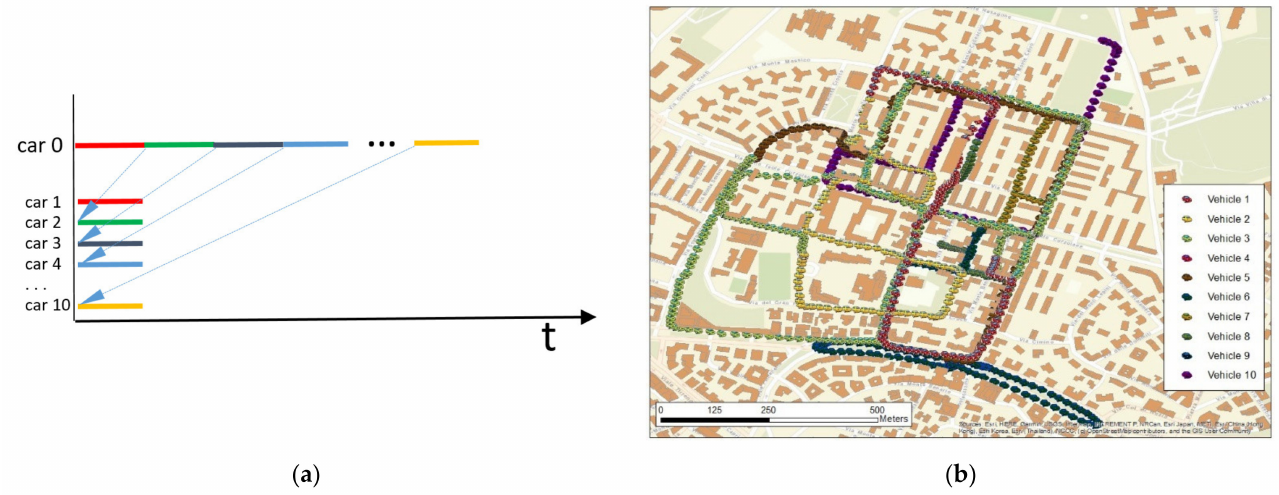
Figure 6. The experimental campaign: ( a ) the rearrangement of the data from a single recording to several smaller recordings; ( b ) the resulting location of data points on the